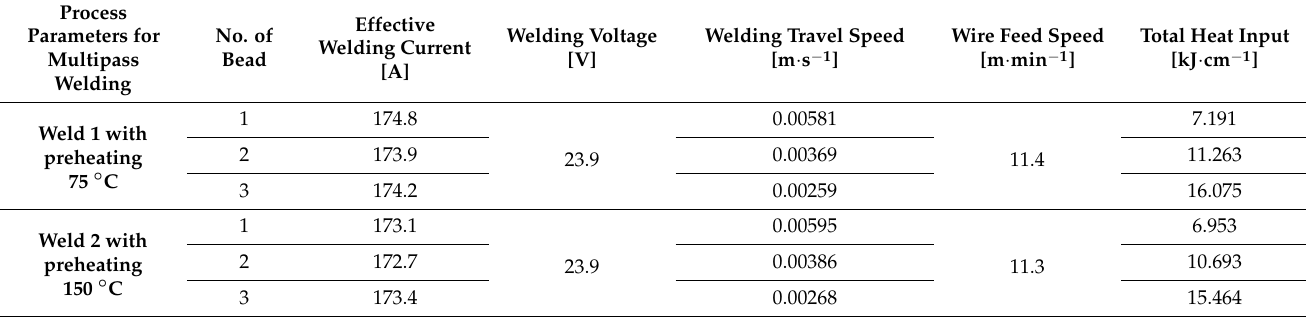
Table 6. Process parameters used for multipass welding at different preheating temperatures. Process Parameters for